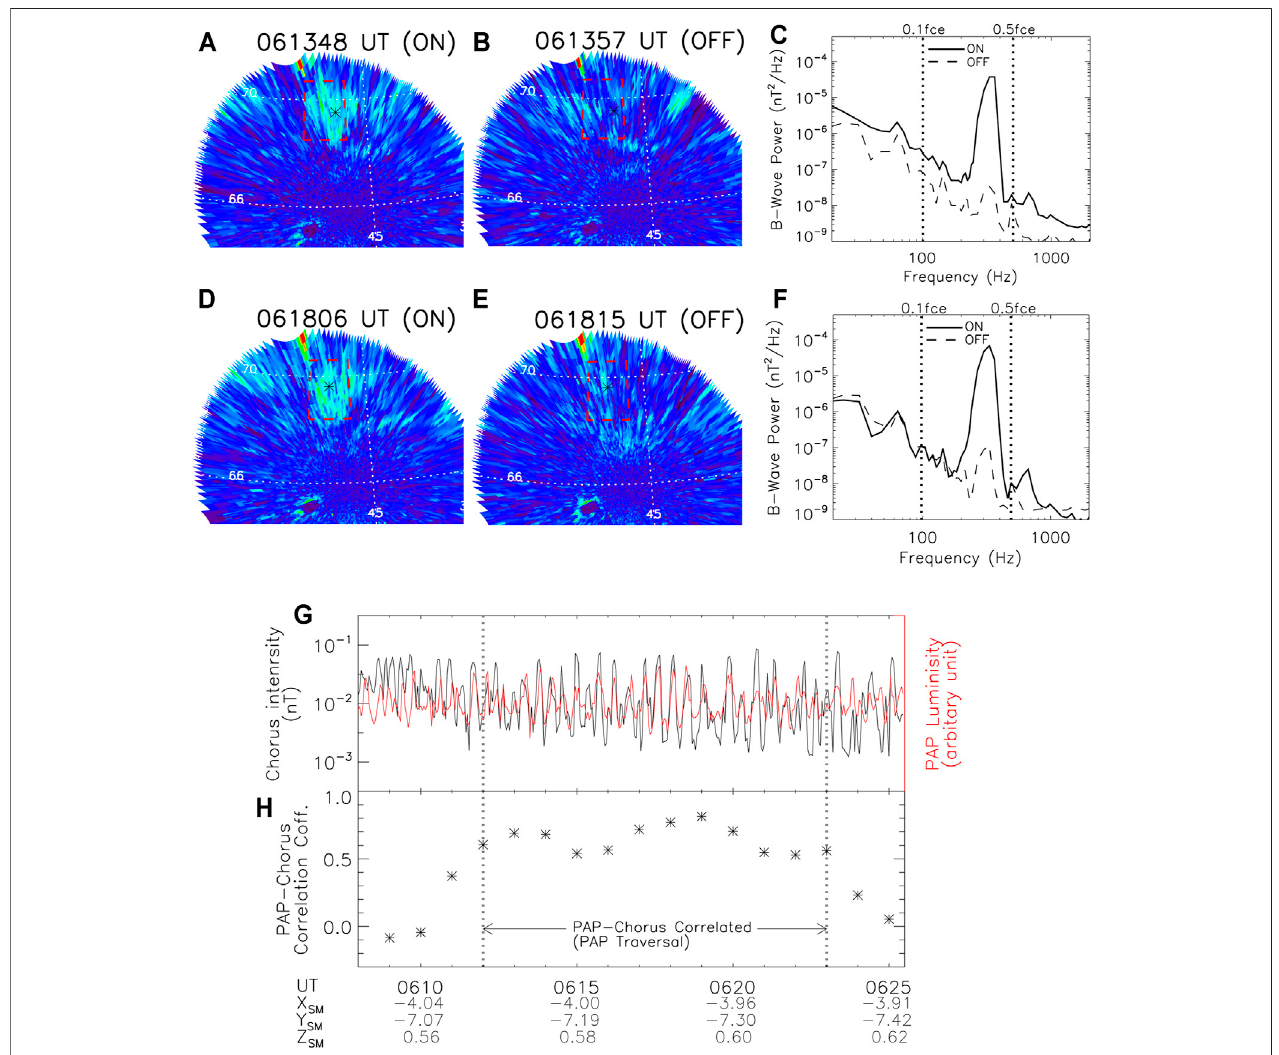
calculated in a 2-min window centered at the time of the data point. SM coordinates of TH-E are labeled under the